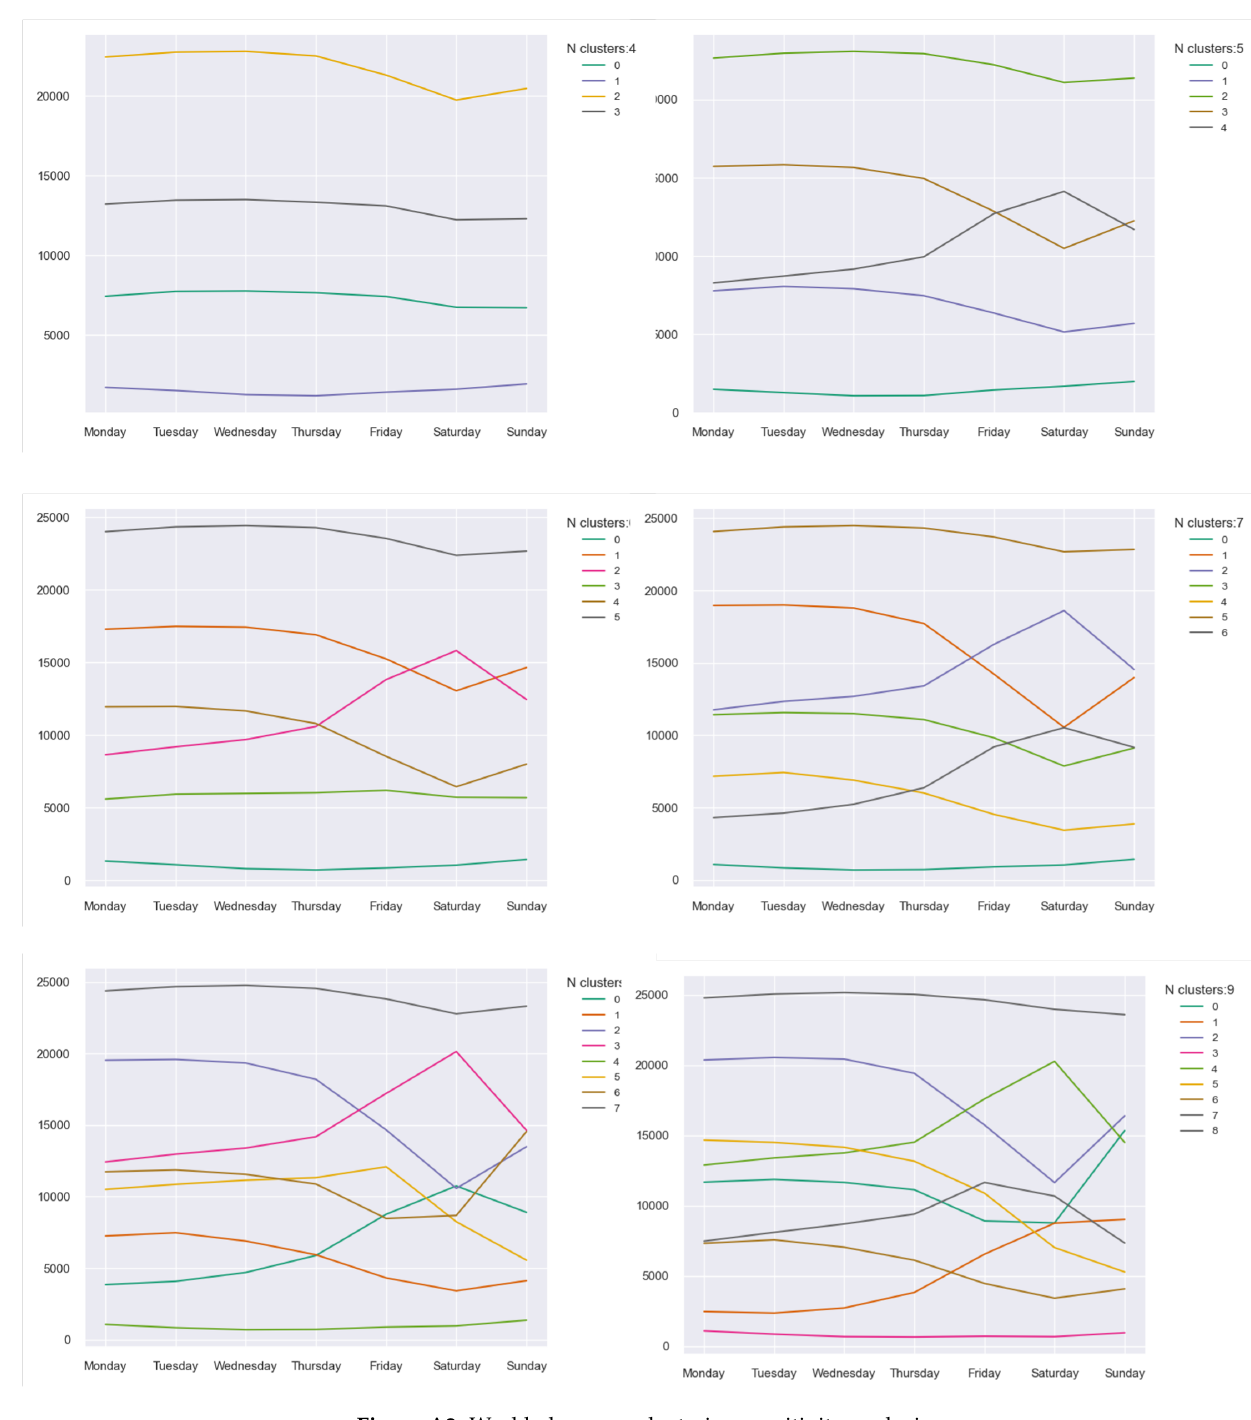
Figure A2. Weekly k-means clustering sensitivity